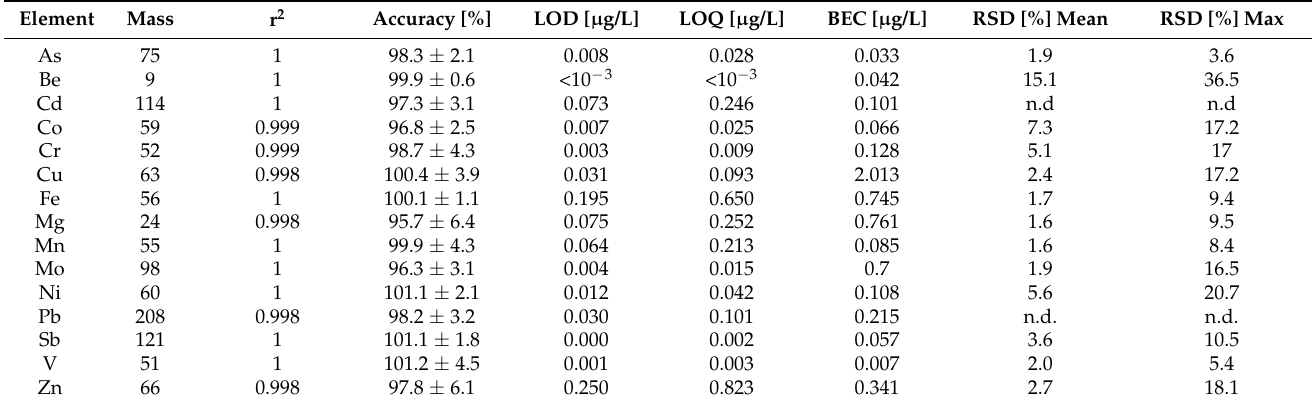
Table 1. Validation parameters of ICP-MS analysis.